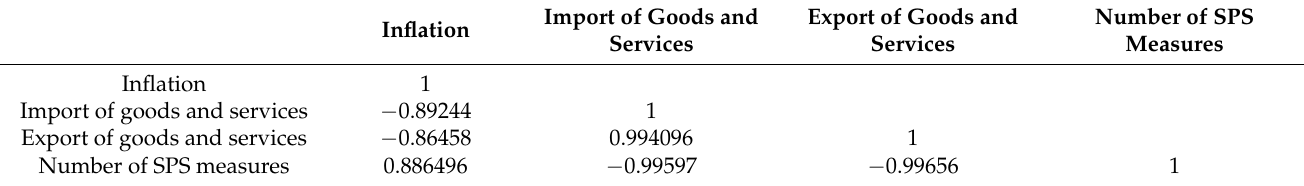
Table 6. Results of correlation analysis of inflation and trade integration factors.